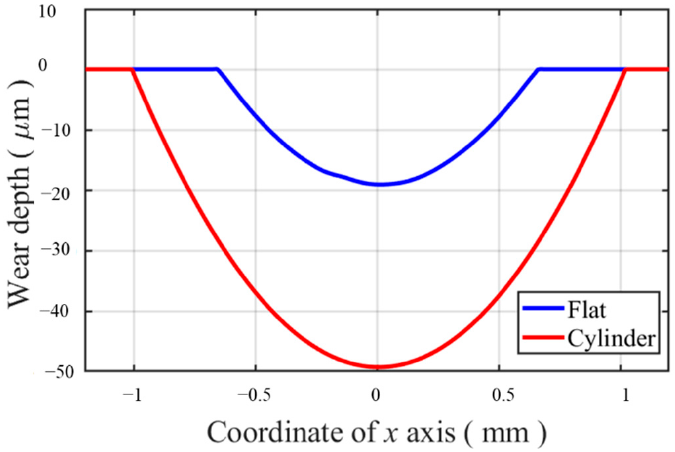
Figure 12. Wear characteristics of both specimens after 25,000 cycles.